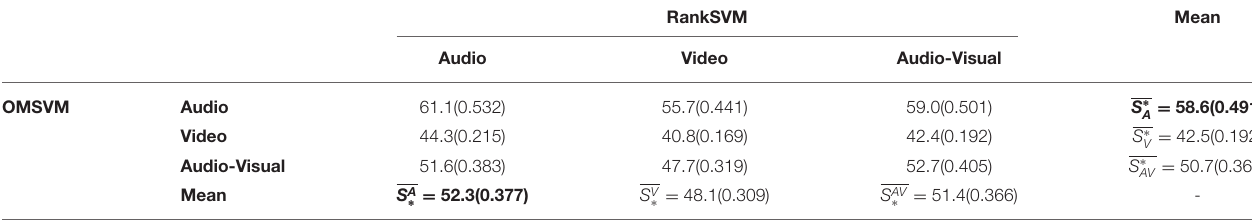
TABLE 4 | Performance of Arousal prediction in terms of Unweighted Average Recall (UAR %) and weighted kappa k w (reported inside parenthesis).